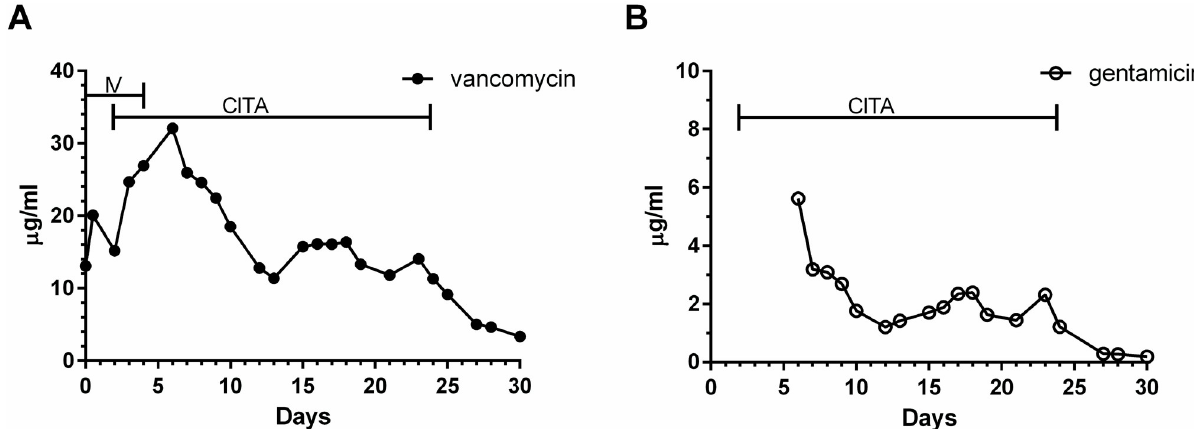
Fig 4. A patient with an infected knee following knee replacement was initially treated with intravenous vancomycin. CITA treatment started on the day of surgery (day 2), and intravenous therapy was stopped on day 4. CITA treatment was stopped on the 24th day. Cultures demonstrated methicillin-resistant S . aureus and P . aeruginosa